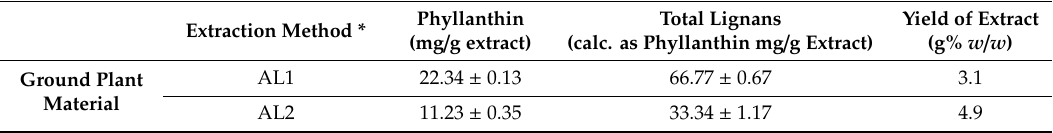
Table 2. E ff ect of di ff erent alkaline digestion conditions on phyllanthin and total lignan